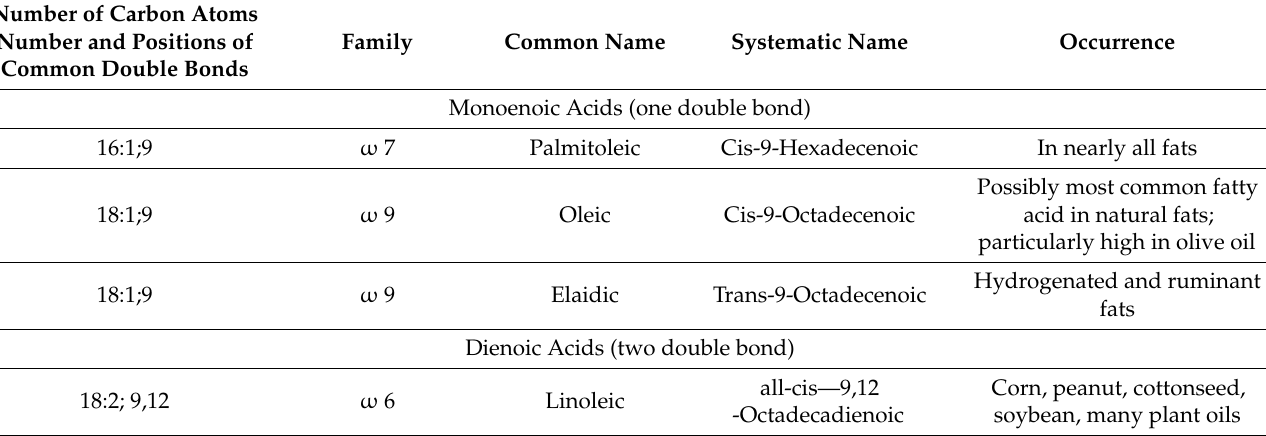
Table 3. Unsaturated Fatty Acids